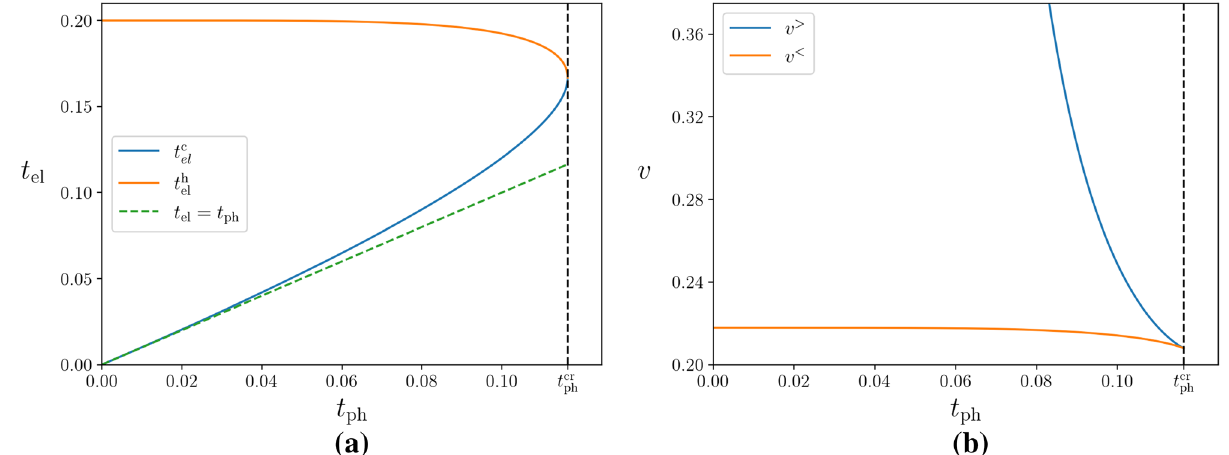
Figure 2. Dependence of the bistability boundaries on the phonon temperature for (a) the electron temperature and (b) the source-drain voltage, for γ = 1 . The region of electron temperatures inside the curve (a) is experimentally inaccessible as it corresponds to the unstable